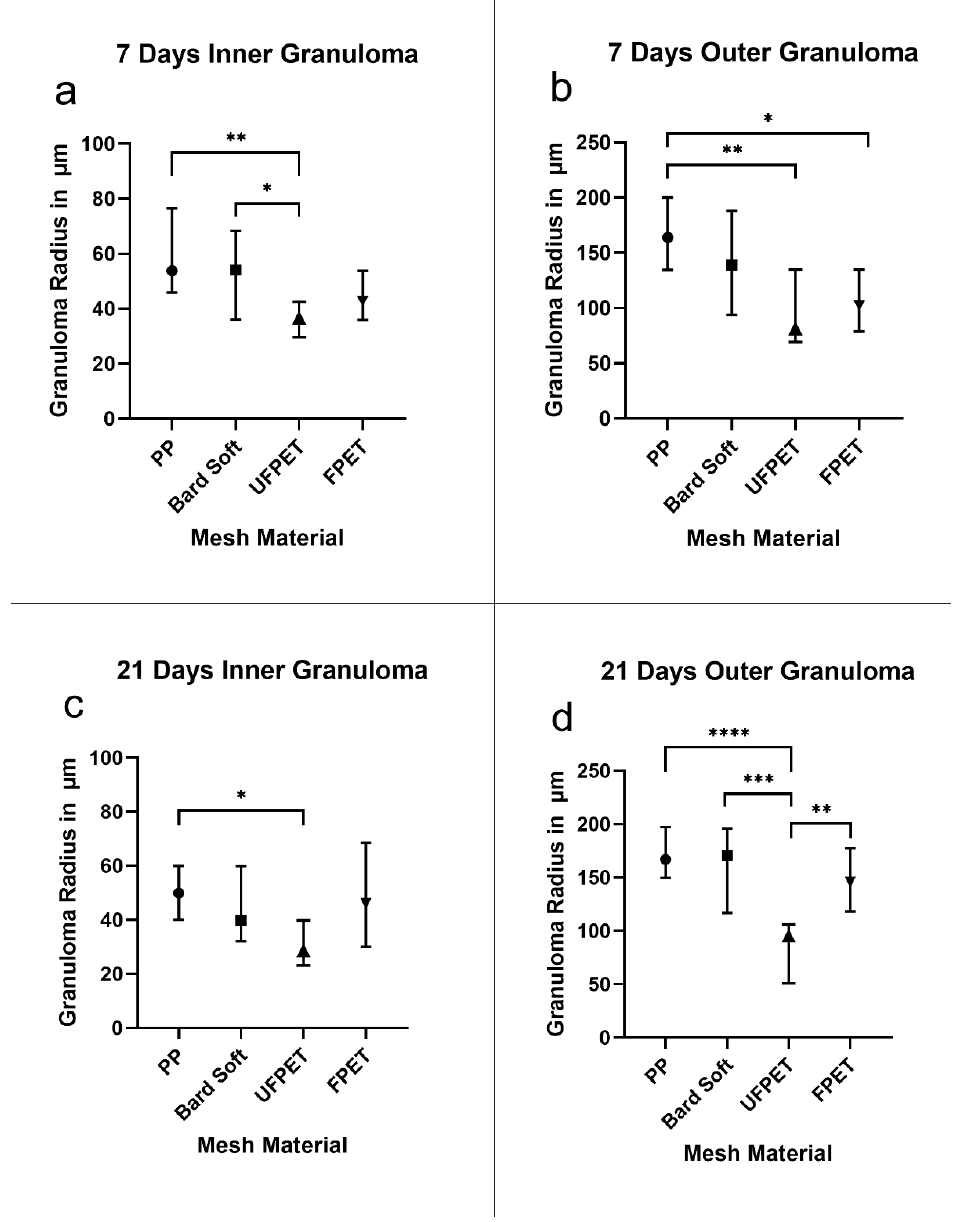
Figure 4. Foreign body granuloma sizes measured in µm. Asterisks denote significance levels of the Kruskal–Wallis analysis. ( a ) 7 days inner granuloma, ( b ) seven days outer granuloma, ( c ) 21 days inner granuloma, ( d ) 21 days outer Granuloma: * p < 0.05, ** p < 0.01, *** p < 0.001, and **** p < 0.0001.